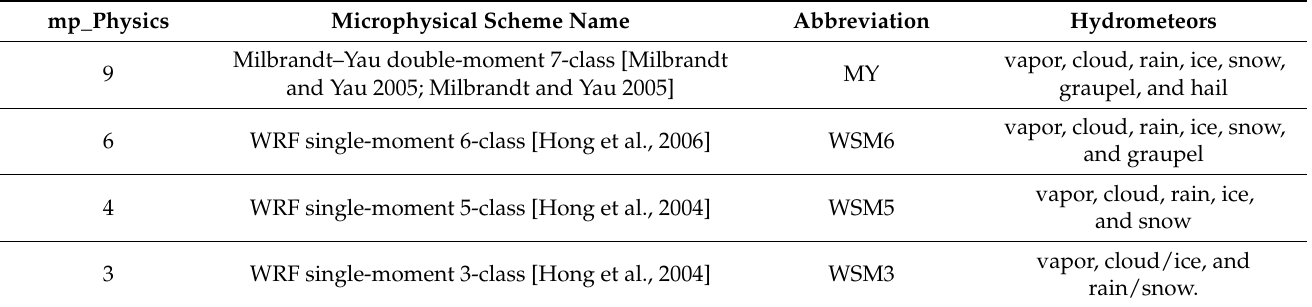
Table 3. WRF v3.7.1. Cloud microphysical schemes used for the Phailin